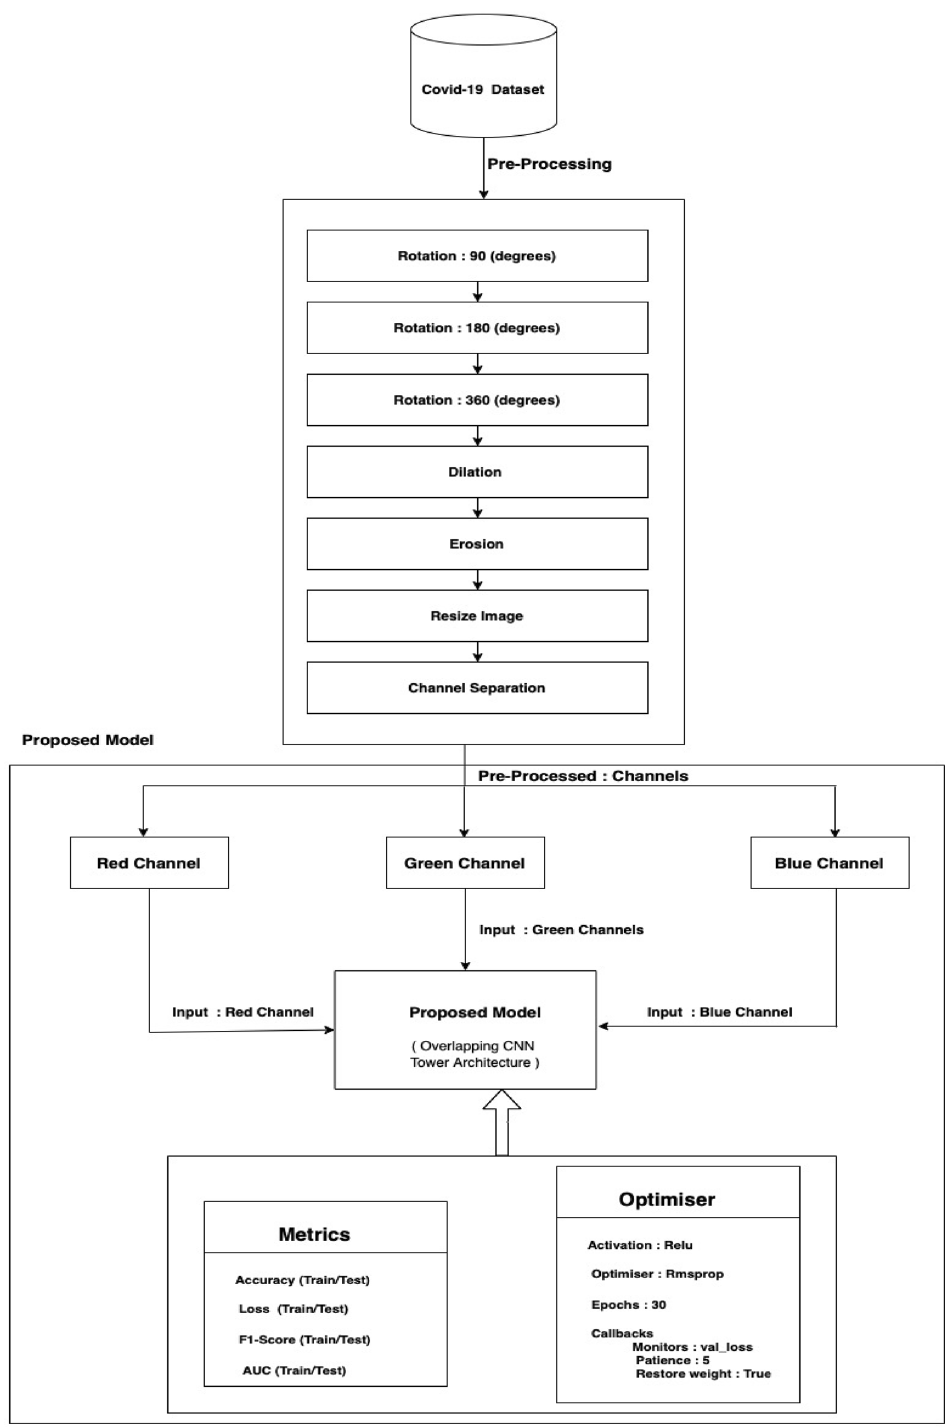
Figure 1. The framework of the proposed